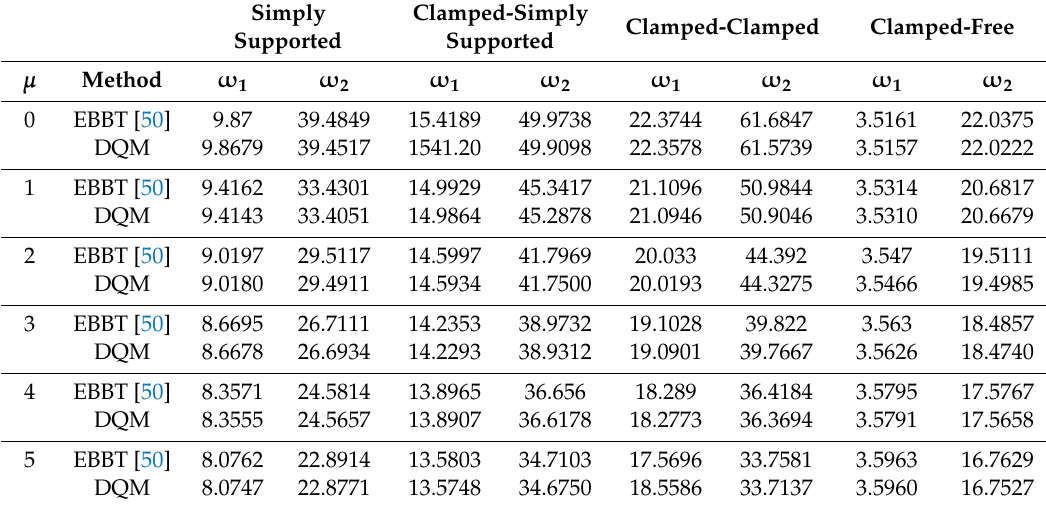
Table 3. Sensitivity of the size-dependent natural frequencies for di ff erent nonlocal parameters and boundary conditions.